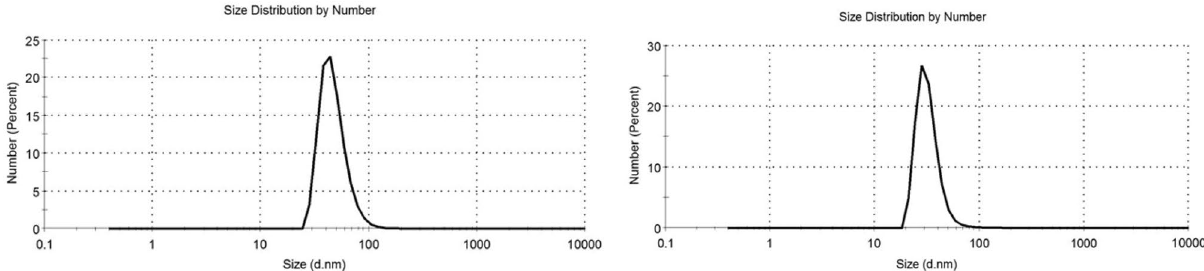
Figure 6. DLS measures showing size distribution of iron nanoparticles synthesized by Aspergillus flavipes MN956655.1.